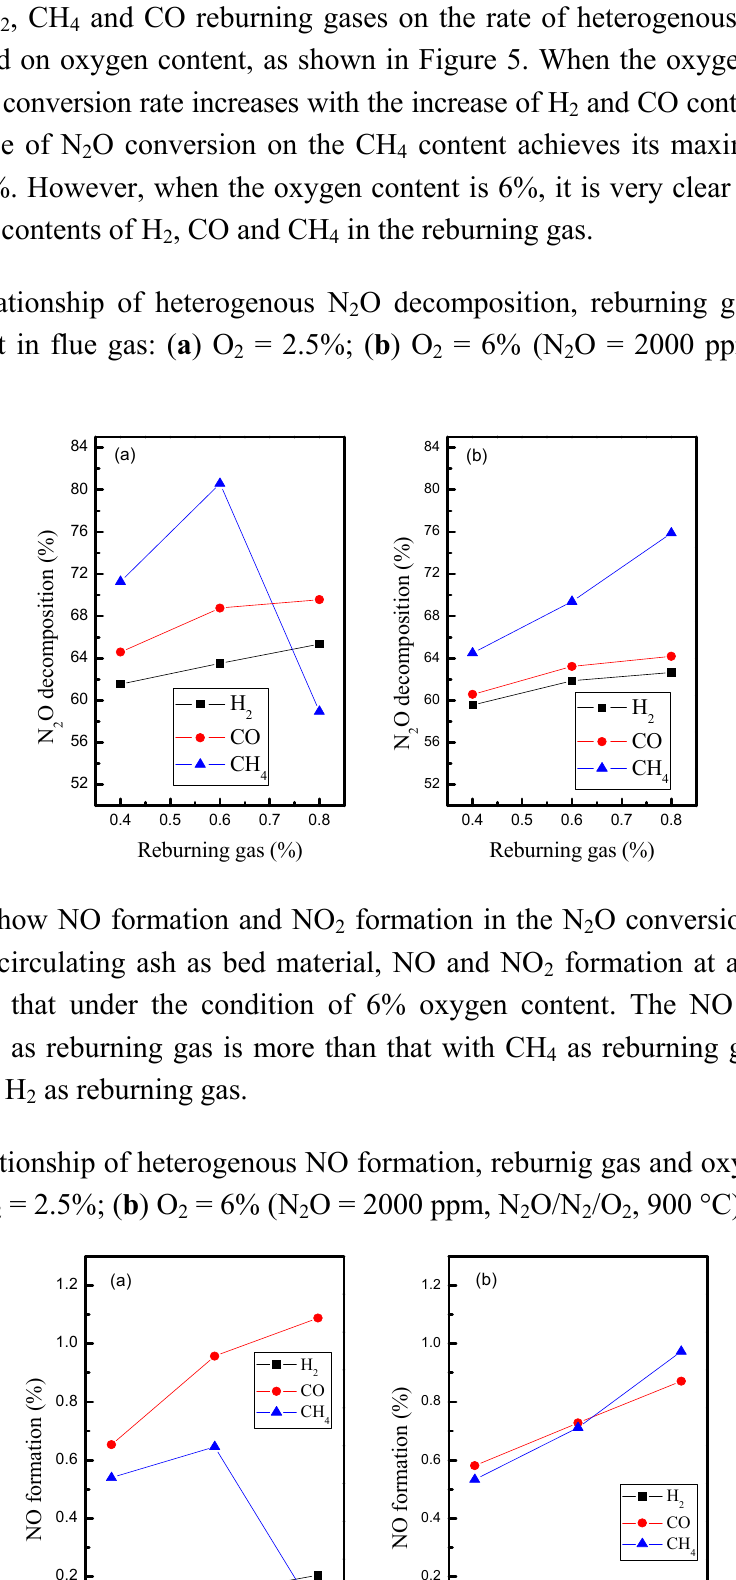
O decomposition, reburning gas content and 2 = 2.5%; ( b ) O = 6% (N O = 2000 ppm, N 2 2 2